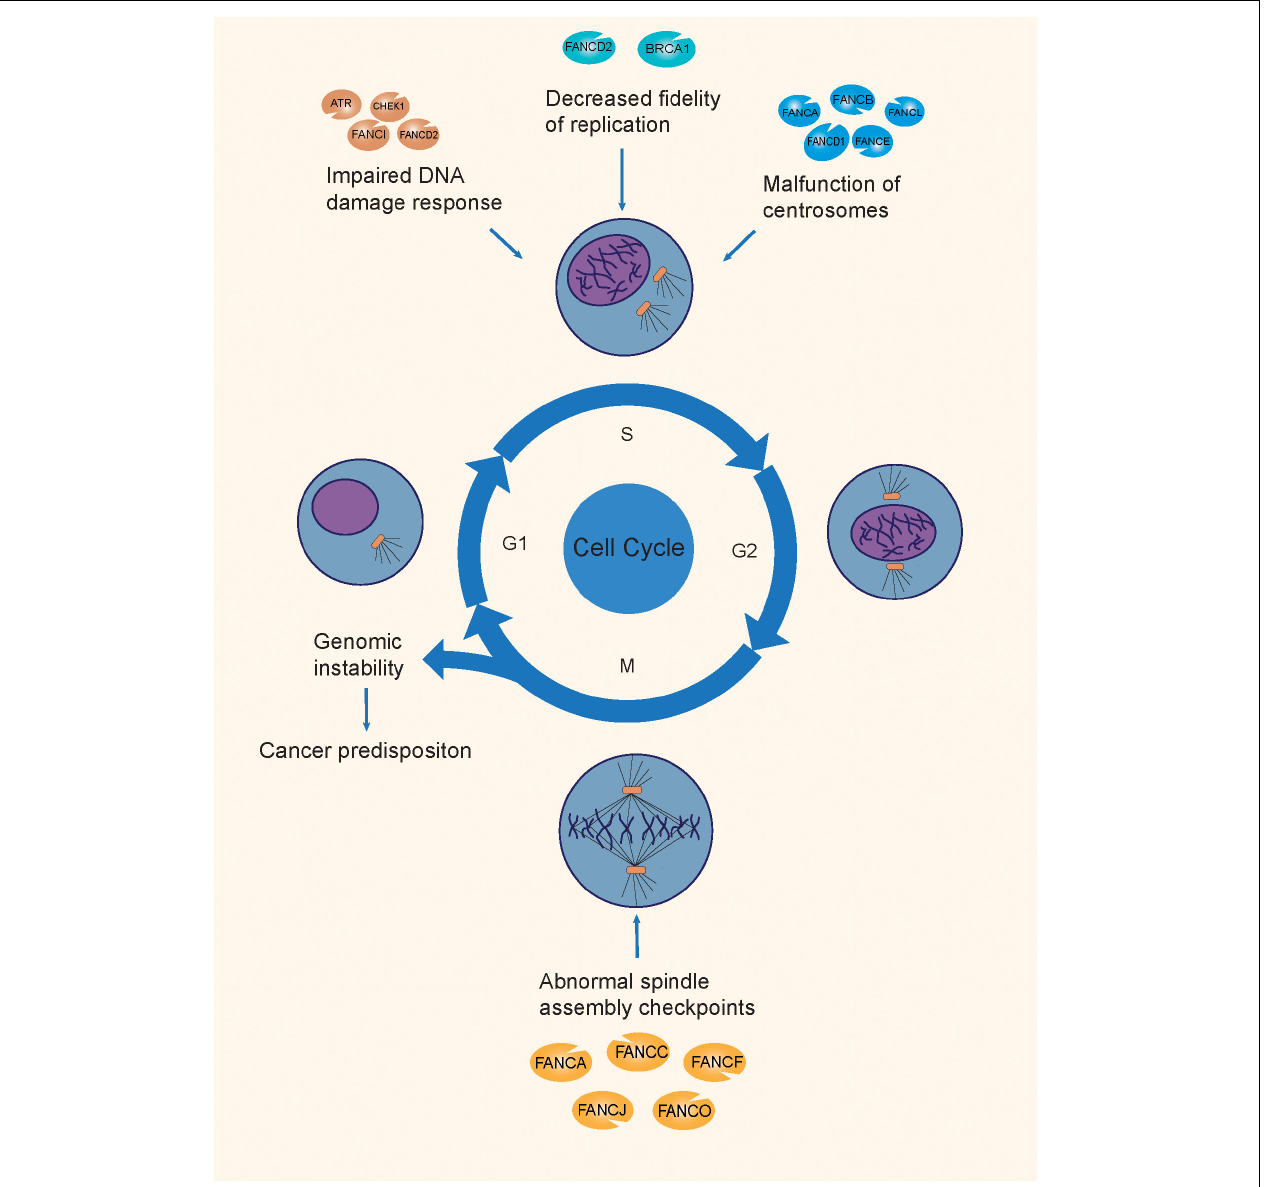
FIGURE 2 | The mechanisms of tumorigenesis attributable to FA mutations. FA genes maintain genomic integrity through the different phases of the cell cycle, by participating in the DDR process, replication fork protection, normal centrosome function, and spindle assembly checkpoints. Mutations on different FA genes are involved in different mechanisms during the cell cycle, causing genomic instability, and causing a predisposition to